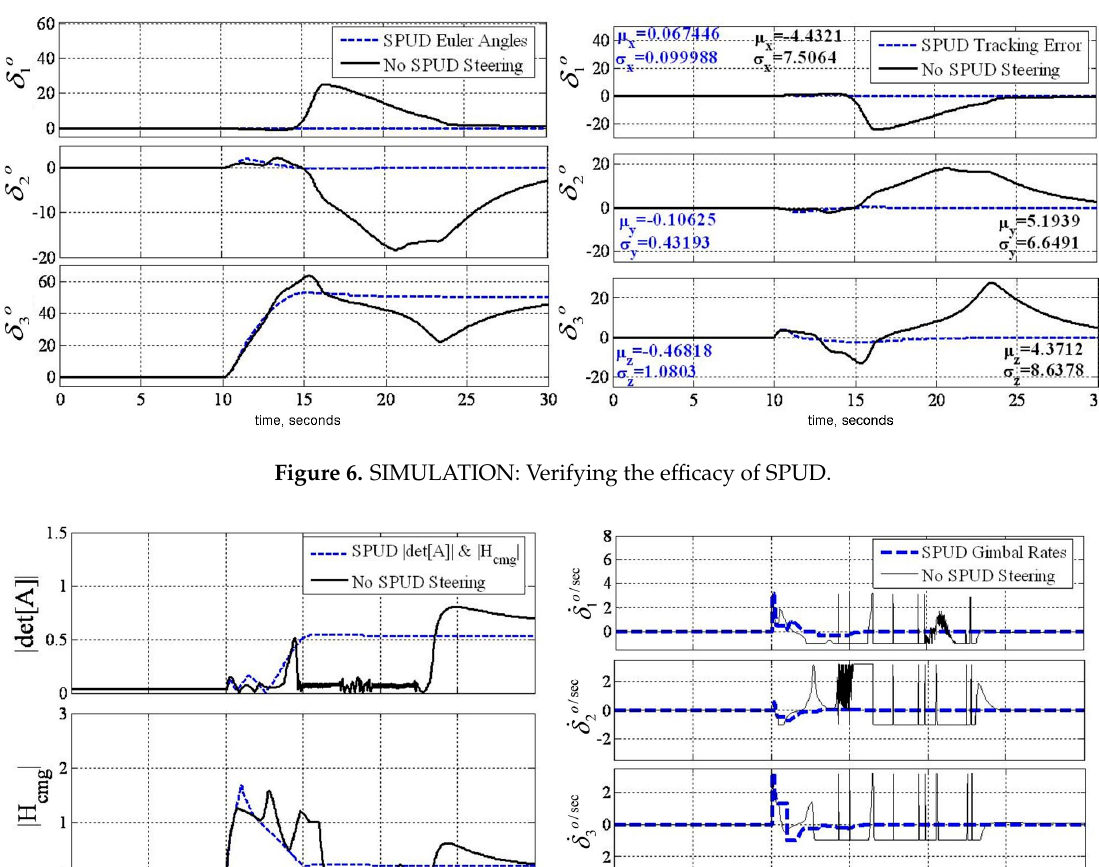
Figure 8. SIMULATION: Gimbal angles associated with Figures 6 and 7. 3.3. Experimental Verification 3.3.1. Decoupled Control Simulation Figure 9 displays the experimental results validating decoupled control, where the geometry is the baseline (maximizes yaw momentum space). The left plot reveals penetration and safe traverse of the singularities, yielding the ability to perform a very large angle yaw maneuver displayed in the right plot. The commanded maneuver angle used in the prequel literature [26,40–42] was increased 700% from ±5 ° in 4 s to ±35 ° in 10 s to show-off the capabilities of decoupled steering. This new yaw maneuver commands significantly higher momentum change. Figure 9 reveals this new enhanced